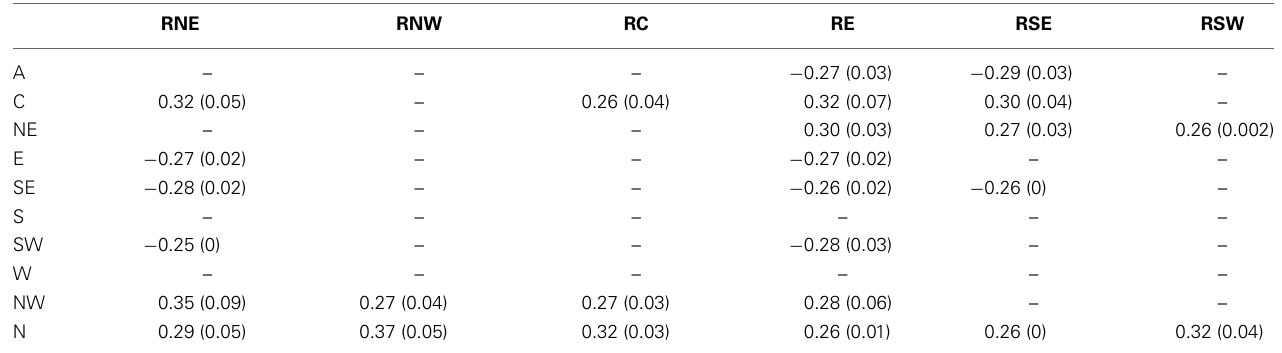
Table 6 | As in Table 5, but for